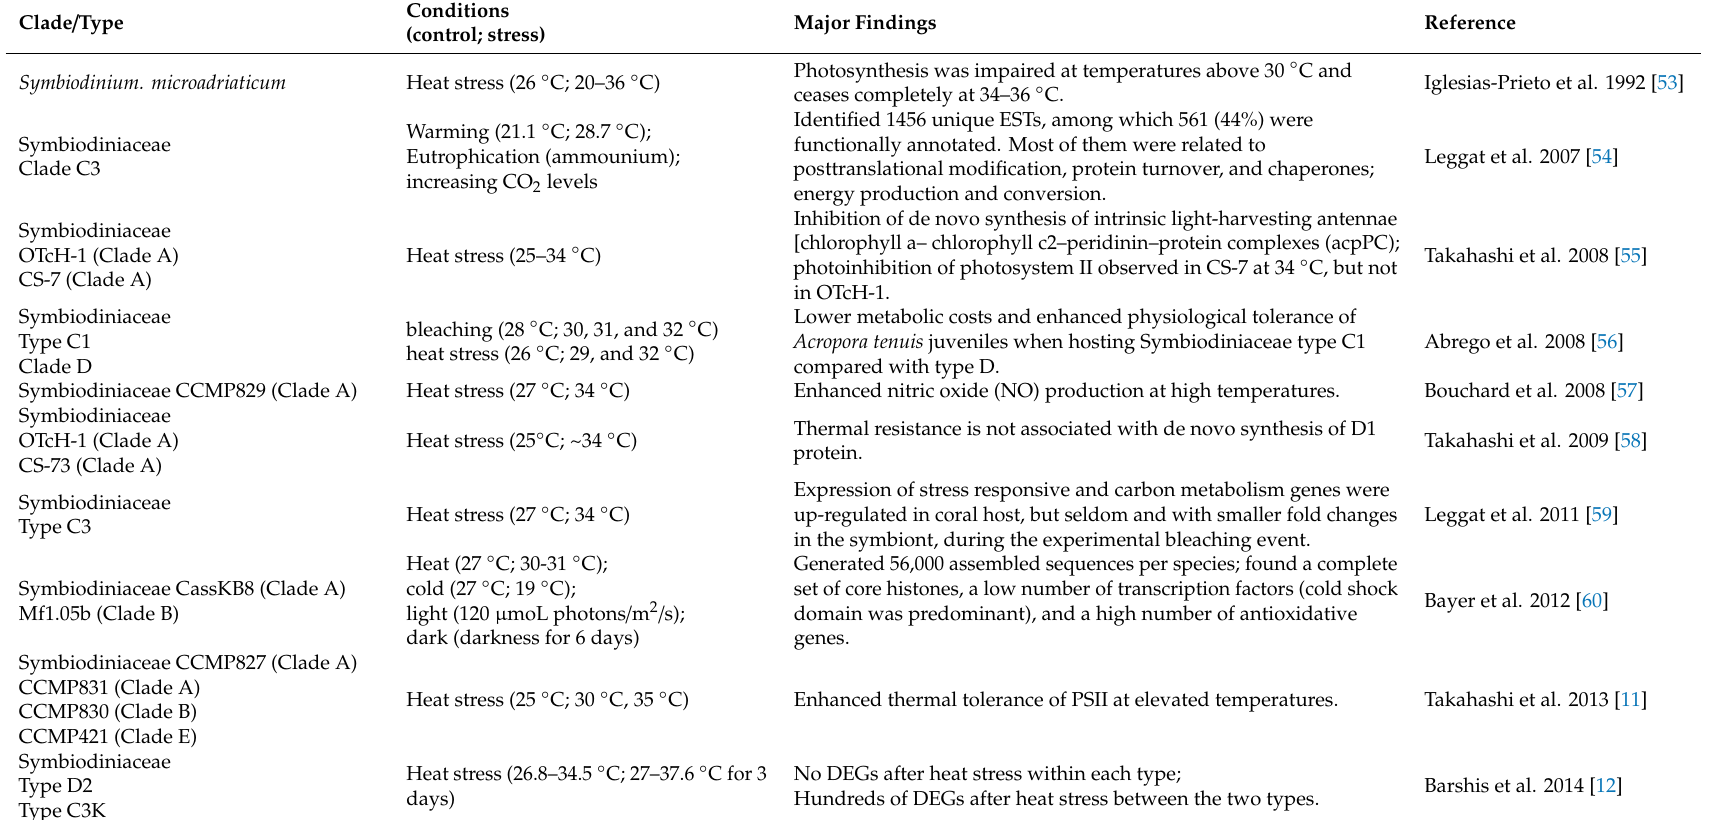
Table 3. Major findings of previous heat stress related studies on